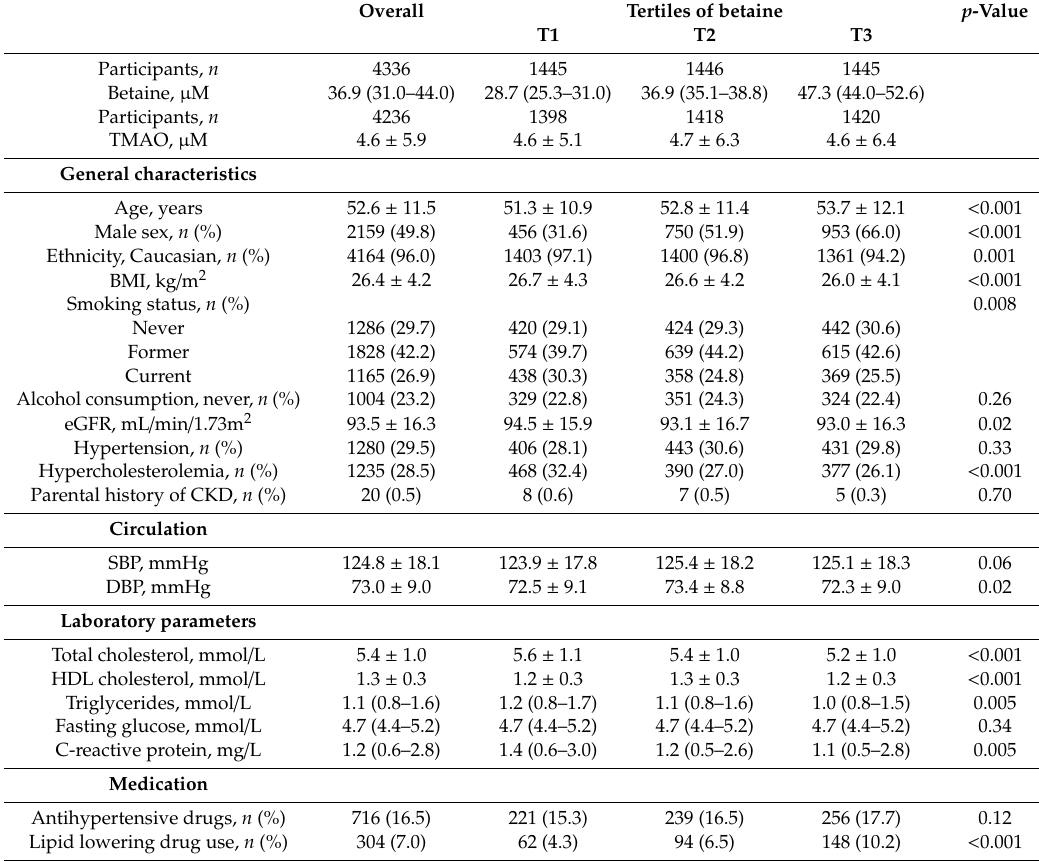
Table 3. Baseline characteristics of the 4336 subjects of the Prevention of Renal and Vascular End-Stage Disease (PREVEND) study of the overall population and according to tertiles of